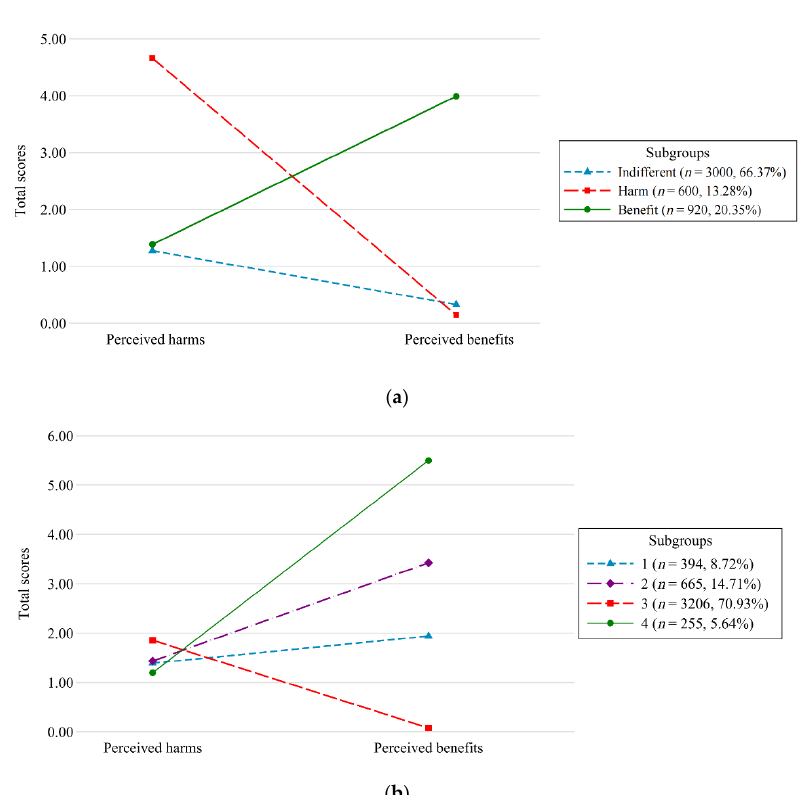
Figure 1. ( a ) The patterns of perceived harms and benefits of the COVID-19 outbreak in three subgroups; ( b ) The patterns of perceived harms and benefits of the COVID-19 outbreak in four subgroups. Note: The y -axis indicates the total scores of perceived harms or benefits.